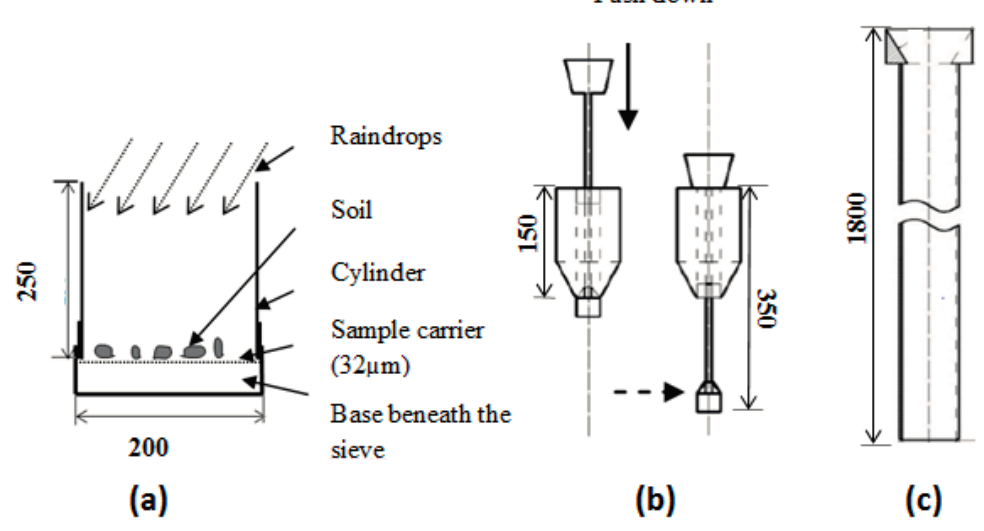
Figure 1. The sketch of the raindrop aggregate destruction test (RADT) used in this study ( a ); injection device ( b ); and settling tube (ST) apparatus ( c ) developed by Hu et al. [57]. All measurements given in